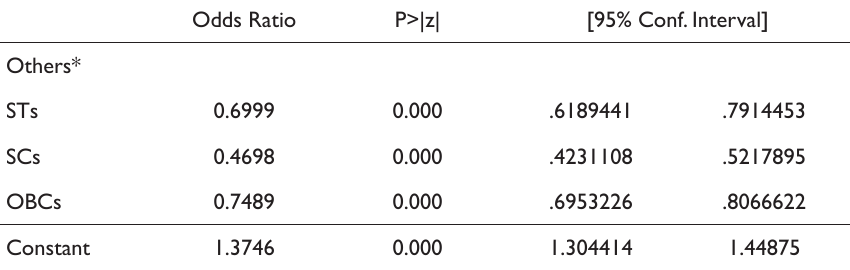
Table 4. Logistic Regression Model for Social Groups in